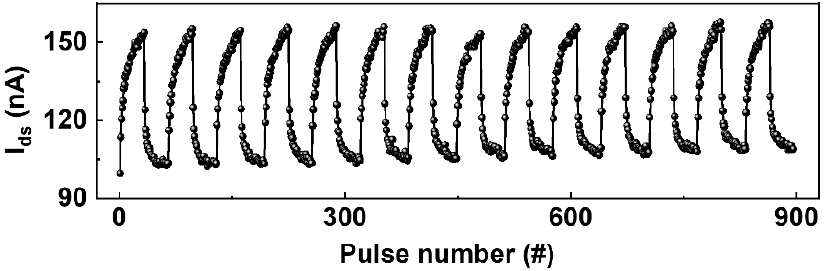
Figure 4. Iterative measurement of 896 pulses in potentiation and depression